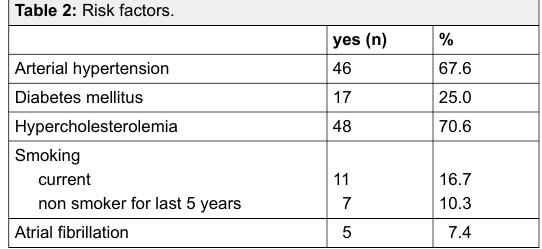
Table 2: Risk factors.